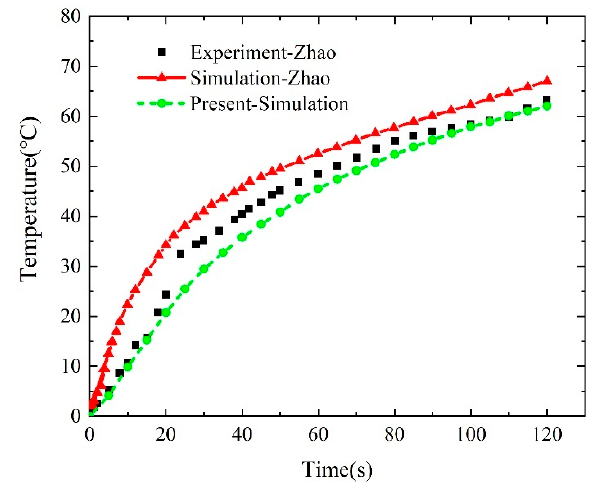
Figure 2. Temperature rise in the hydrogen storage cylinder [21,27].